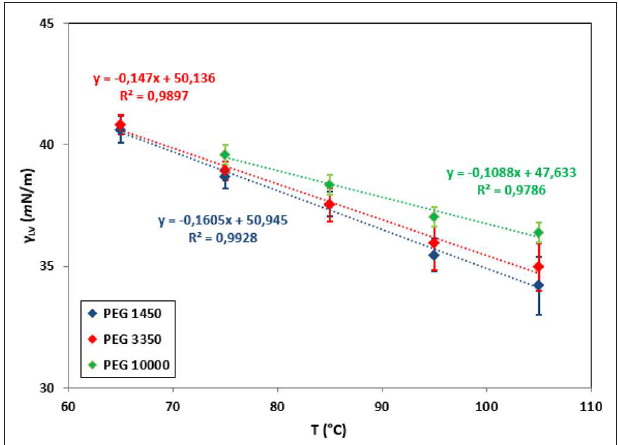
FIGURE 5 | Surface tension as a function of temperature for PEGs.